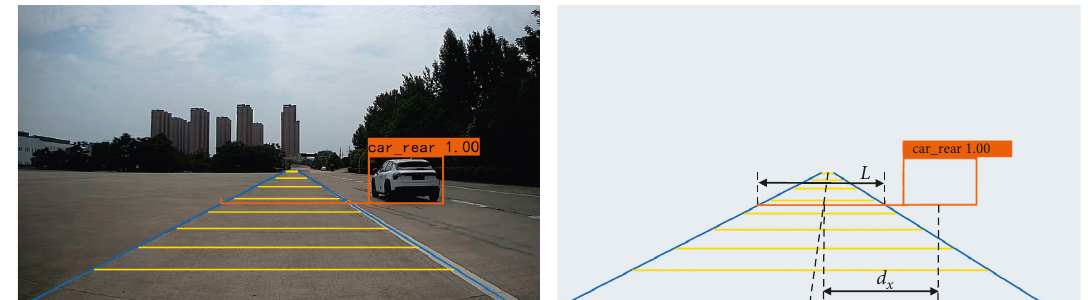
Figure 3: Ranging algorithm based on vehicle target and lane line